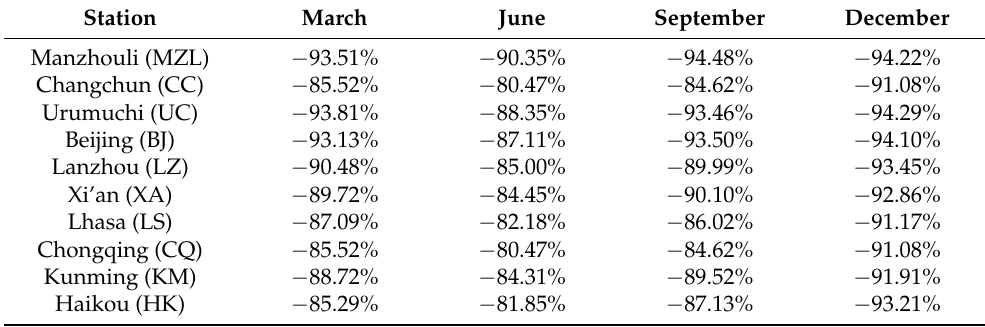
Table 2. Median value for relative change of CSES Ne corresponding to ionosonde Ne at different stations.